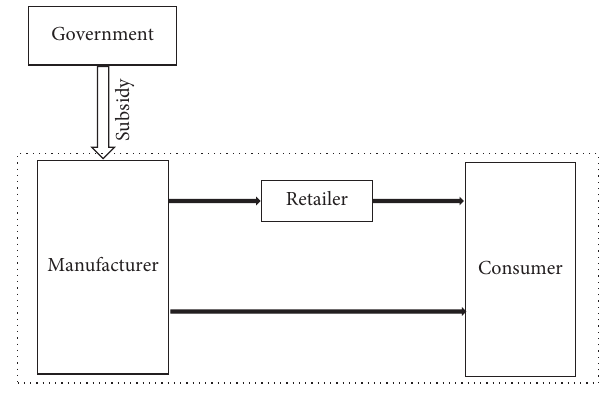
Figure 1: Dual-channel supply